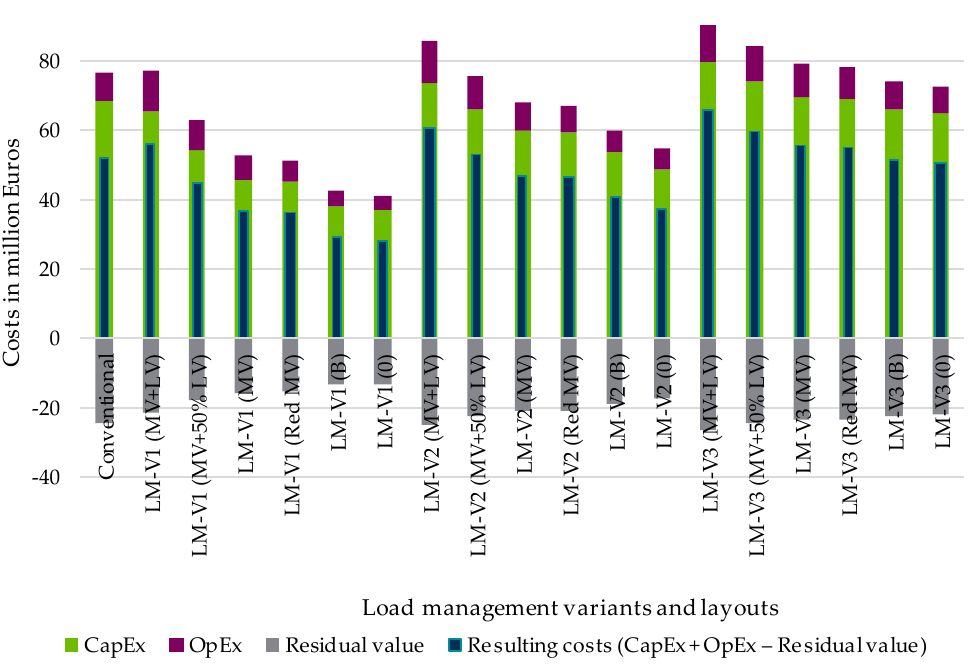
Figure 17. Consolidated costs over eleven medium voltage grids for conventional planning strategy and three load management variants with six layouts based on [59].